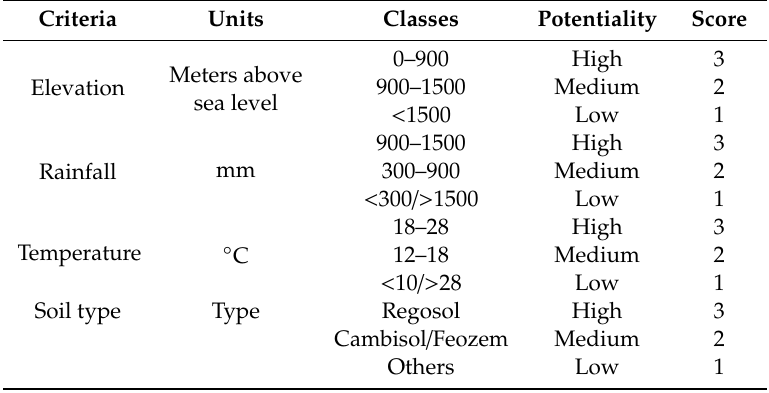
Figure 3. Methodological workflow developed to estimate suitability and availability of land (high potential, medium potential and low potential) for JCL cultivation in Mexico. Table 3. Land Suitability Criteria for JCL cultivation to perform the